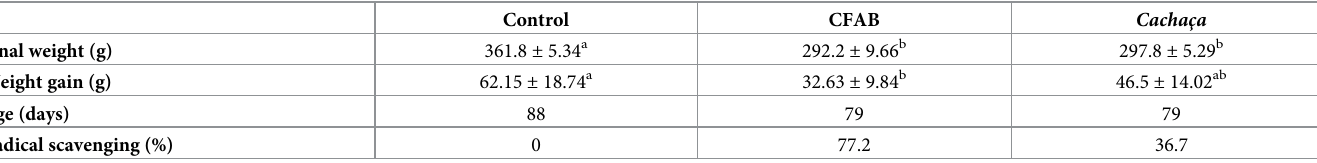
Table 1. Growth performance of young-adult rats (79–88 days of life) treated per gavage with C . vulgaris functional alcoholic beverage (CFAB), cachaça and water.